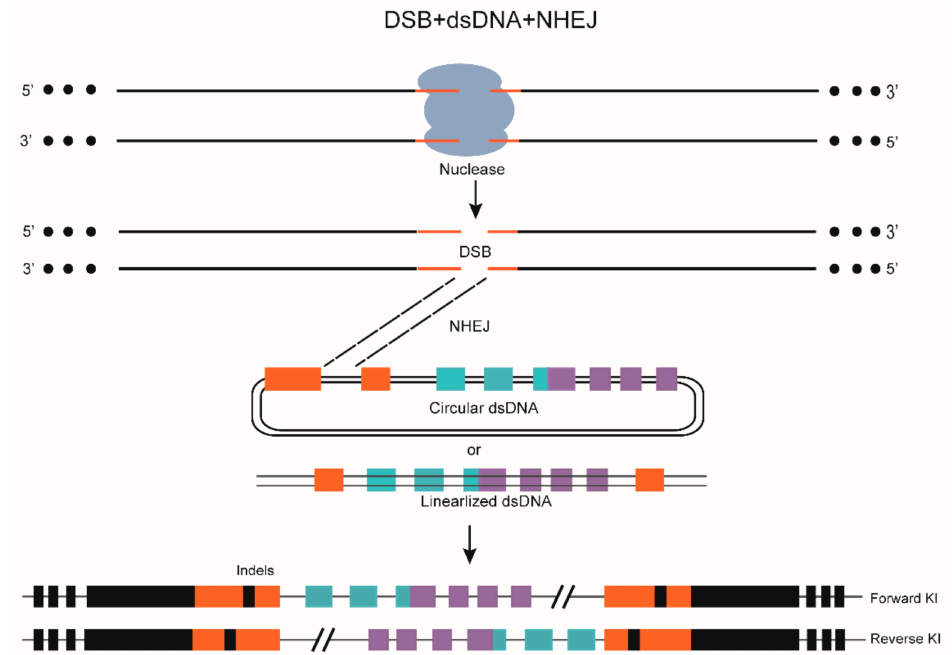
Figure 2. DSB and dsDNA mediated gene editing in zebrafish. ZFN, TALEN, or CRISPR/Cas9 can be used to generate DSBs at the target site. Linearized or circular dsDNA containing the DNA fragment serves as the template. Targeted knock-in (KI) can then proceed via the NHEJ pathway. In addition to forward KI, reverse KI and indels often